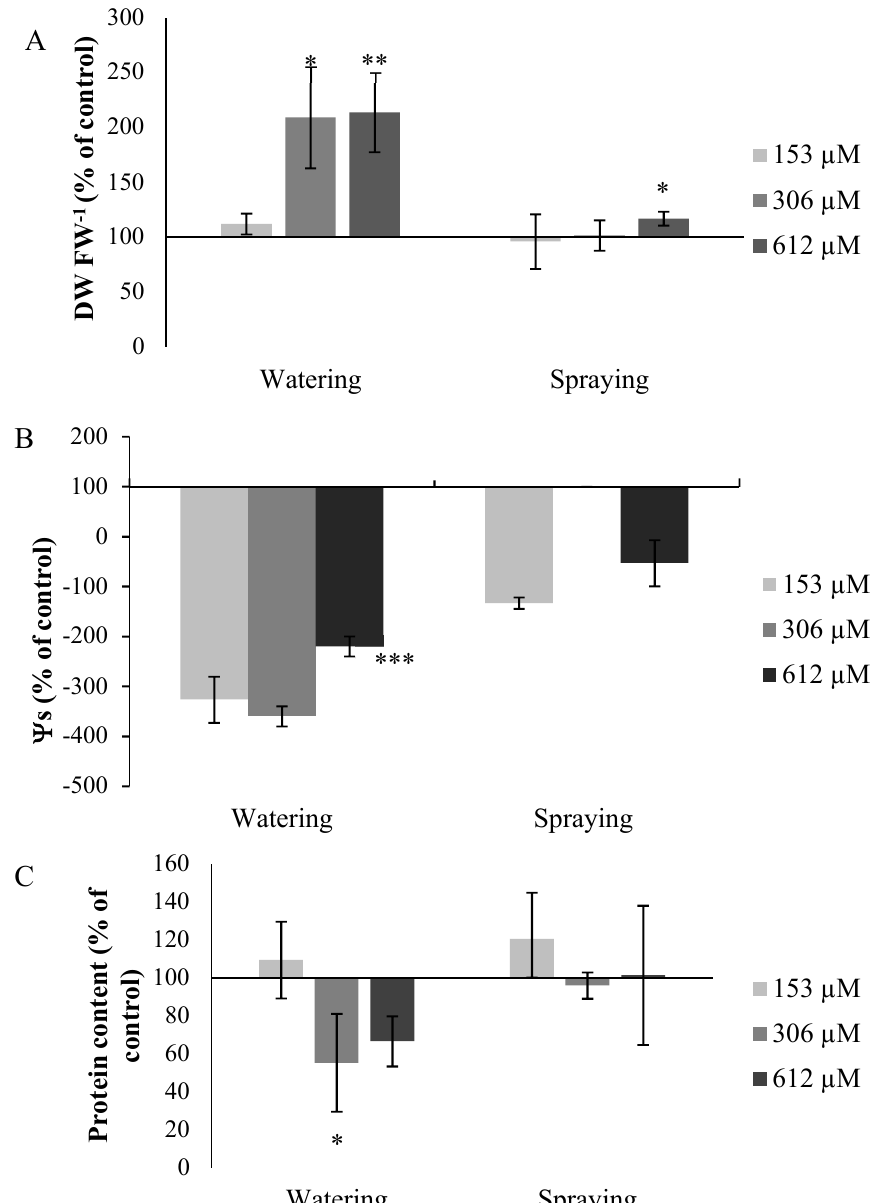
Figure 10. Values for the DW FW −1 ratio ( A ), osmotic potential, Ψs ( B ) and protein content ( C ) of A. thaliana plants watered or sprayed with different concentrations of norharmane (0, 153, 306 and 612 µM) for 21 days. Asterisks indicate significant differences compared to the control (* p ≤ 0.05, ** p ≤ 0.01, *** p ≤ 0.001). Data are given in a percentage with respect to the control.